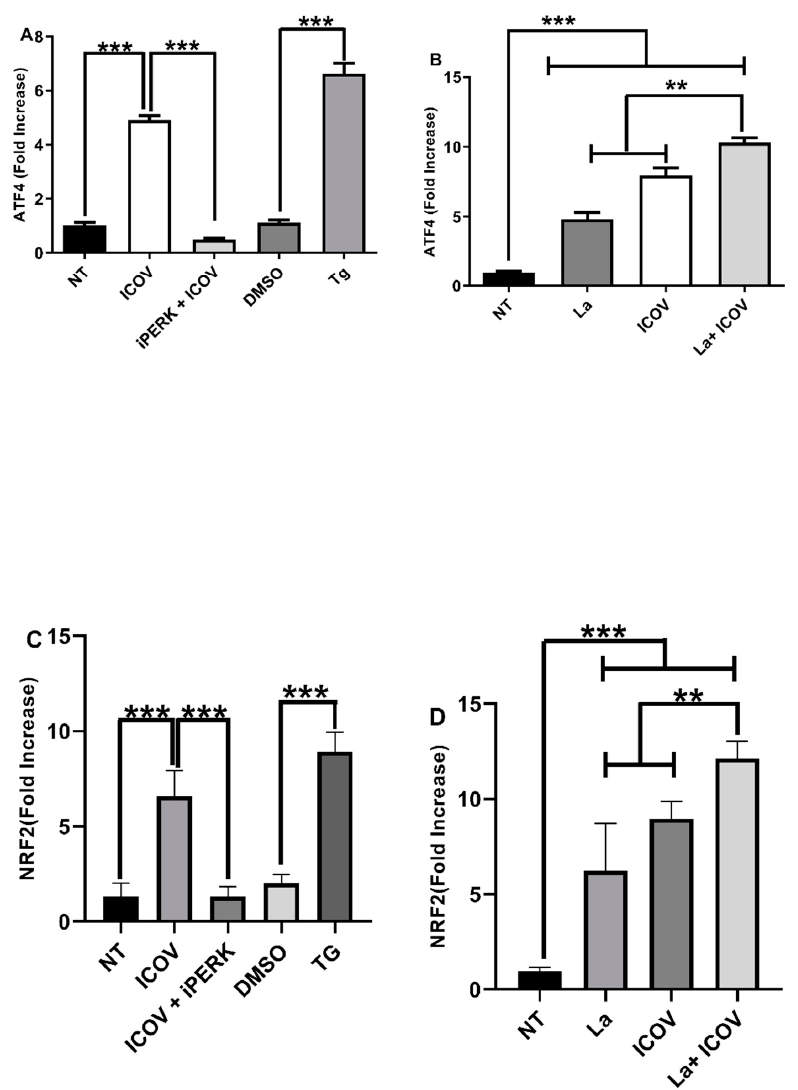
Figure 5. PERK/ATF4 pathway is required during ICOV and the coinfection with L. amazonensis. ATF4 ( A , B ) or NRF2 ( C , D ) transcript levels were measured by qRT-PCR normalized to GAPDH transcript levels after 6 h of treatment and/or infections. Peritoneal macrophages from C57BL/6 mice were not treated (NT), infected with Phlebovirus Icoaraci (ICOV) at MOI 1, pre-treated with 40 nM of PERK inhibitor during 1 h, followed by ICOV infection or treated with 1 µ M Tapsigargin (TG) or DMSO ( A , C ). The same analysis was done during ICOV/ L. amazonensis coinfection ( B , D ). Asterisks indicate significant differences with ** p < 0.001 or *** p < 0.0001.